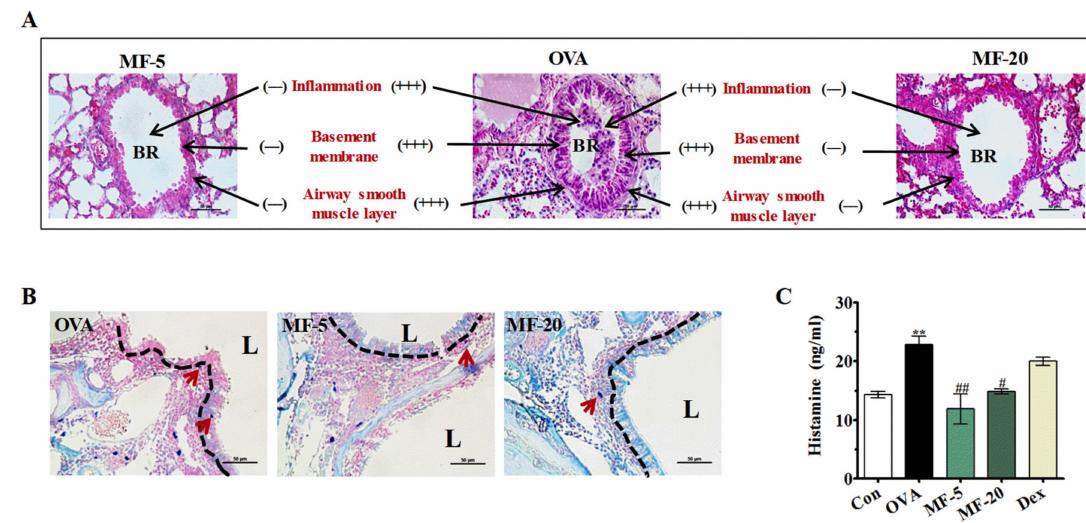
Figure 4. E ff ect of MF on lung histology changes and mast cell migration in OVA-induced AR mice. ( A ) Lung tissues from each group were stained with HE; Scale bar = 100. ( B ) Mast cells immigration and migration to the epithelium. Giemsa staining; Scale bar = 50 µ m. ( C ) The serum levels of histamine. Values are presented as the mean ± SEMs ( n = 6 per group). BR: Bronchus; L: airway lumen. ** p < 0.01 , significantly di ff erent from the value of Control group. # p < 0.05, ## p < 0.01, significantly di ff erent from the value of OVA